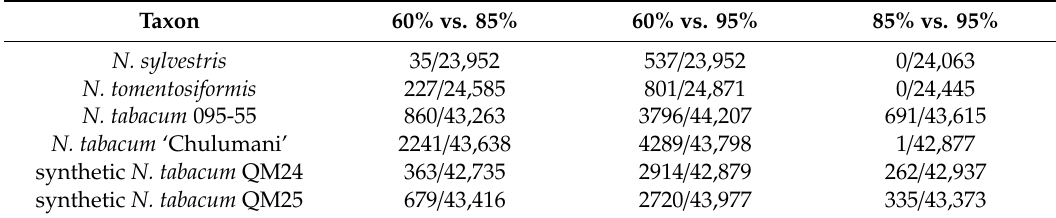
Table 6. Number of di ff erentially expressed contigs within a taxon through the three developmental stages: 60% of anthesis, 85% of anthesis, and 95% of anthesis. The number of di ff erentially expressed contigs with a 4-fold change in expression and FDR less than 0.05 are reported, along with the total number of transcripts present in the given